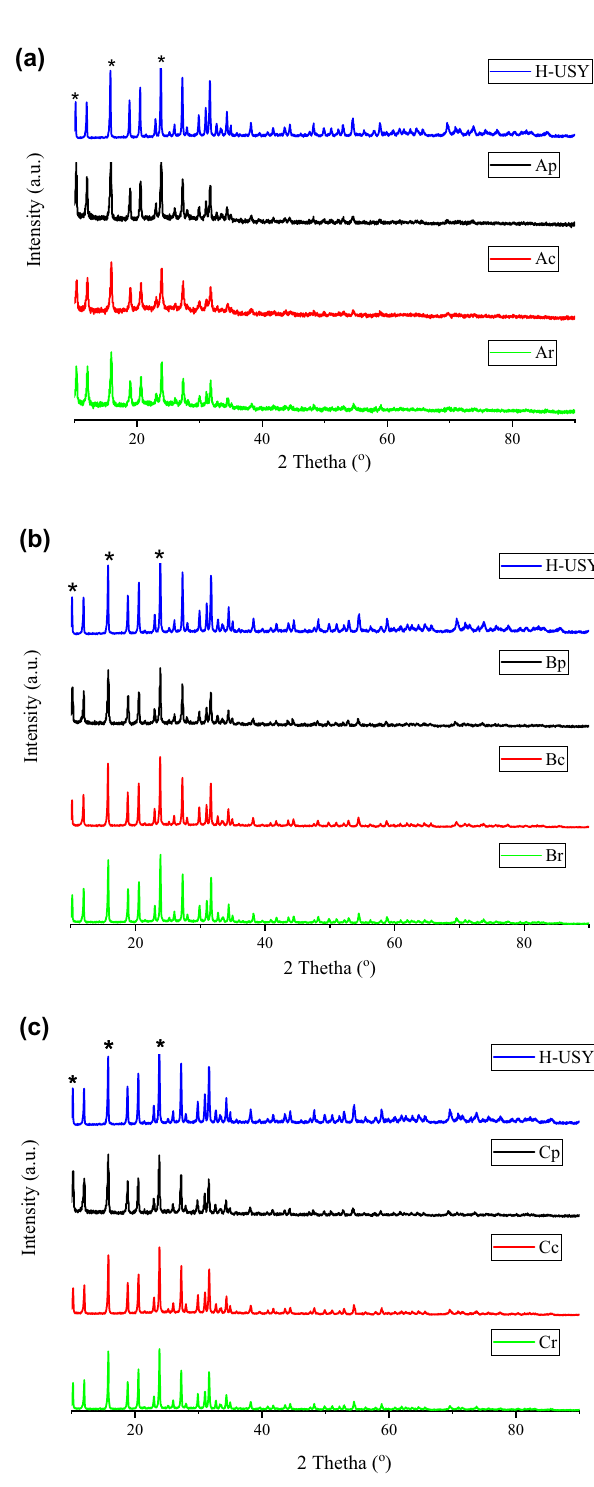
Figure 1: ( a ) Di ff raction patterns of Y zeolite ICSD #31542, and catalyst sample that was produced by impregnation Molybdenum followed by Cobalt precursor after ( Ap ) impregnation, ( Ac ) calcination, and ( Ar ) reduction. ( b ) Di ff ractionpatternsofYzeolite ICSD#31542,and catalyst sample that was produced by impregnation Cobalt followed by Molybdenum precursor after ( Bp ) impregnation, ( Bc ) calcination, ( Br ) reduction. ( c ) Di ff ractionpatternsof ( A ) StandardYzeoliteICSD#31542, and catalyst sample that was produced by co impregnation methods after ( Cp ) impregnation, ( Cc ) calcination, ( Cr )